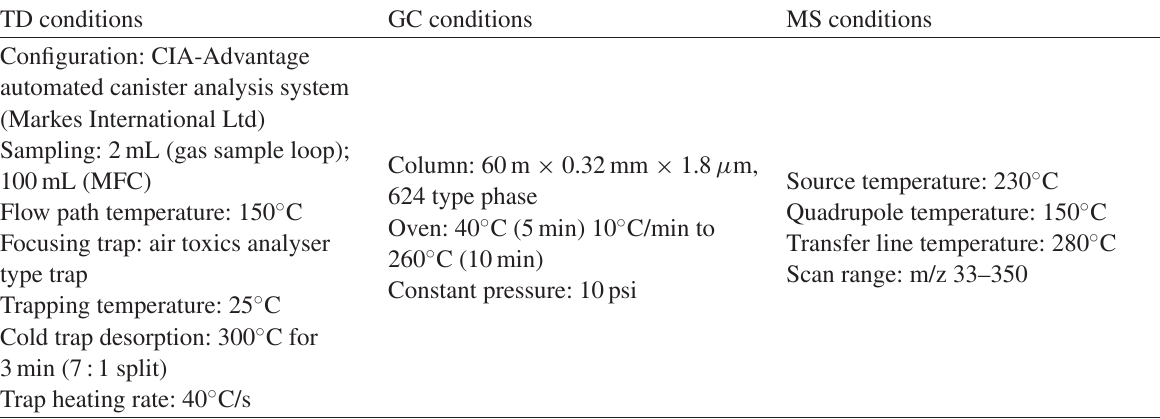
TABLE 4: Analytical